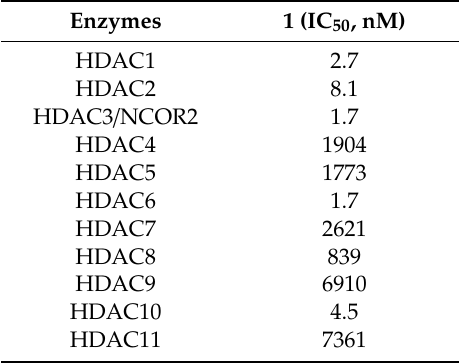
Table 1. Inhibition activities of lead compound 1 against 11 Zn 2 + -dependent HDAC